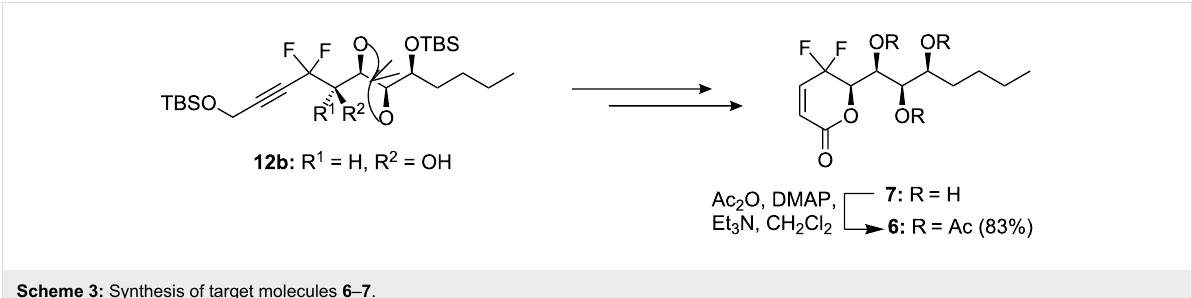
Scheme 3: Synthesis of target molecules 6 – 7